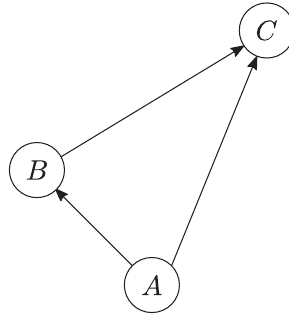
and with B a parent of C